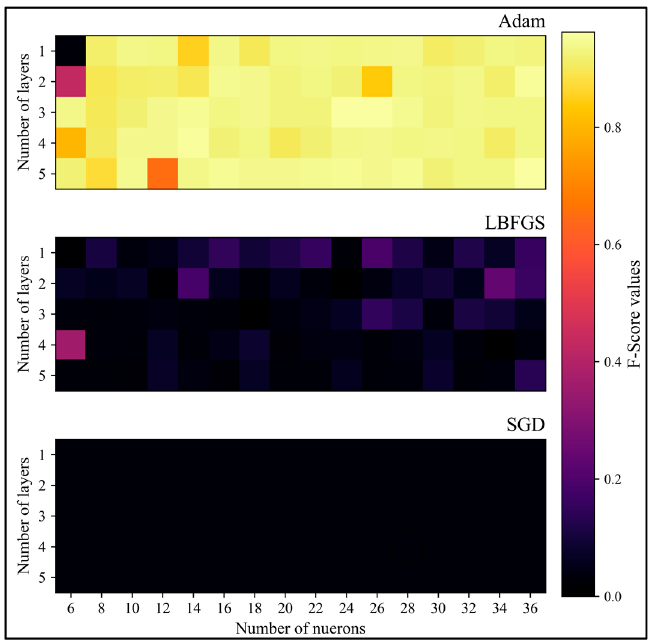
Figure 9. The F ‐ score values of the grid search of the artificial neural network (ANN) algorithm with different topologies (i.e., number of layers and neurons) and three learning algorithms using untransformed input data.